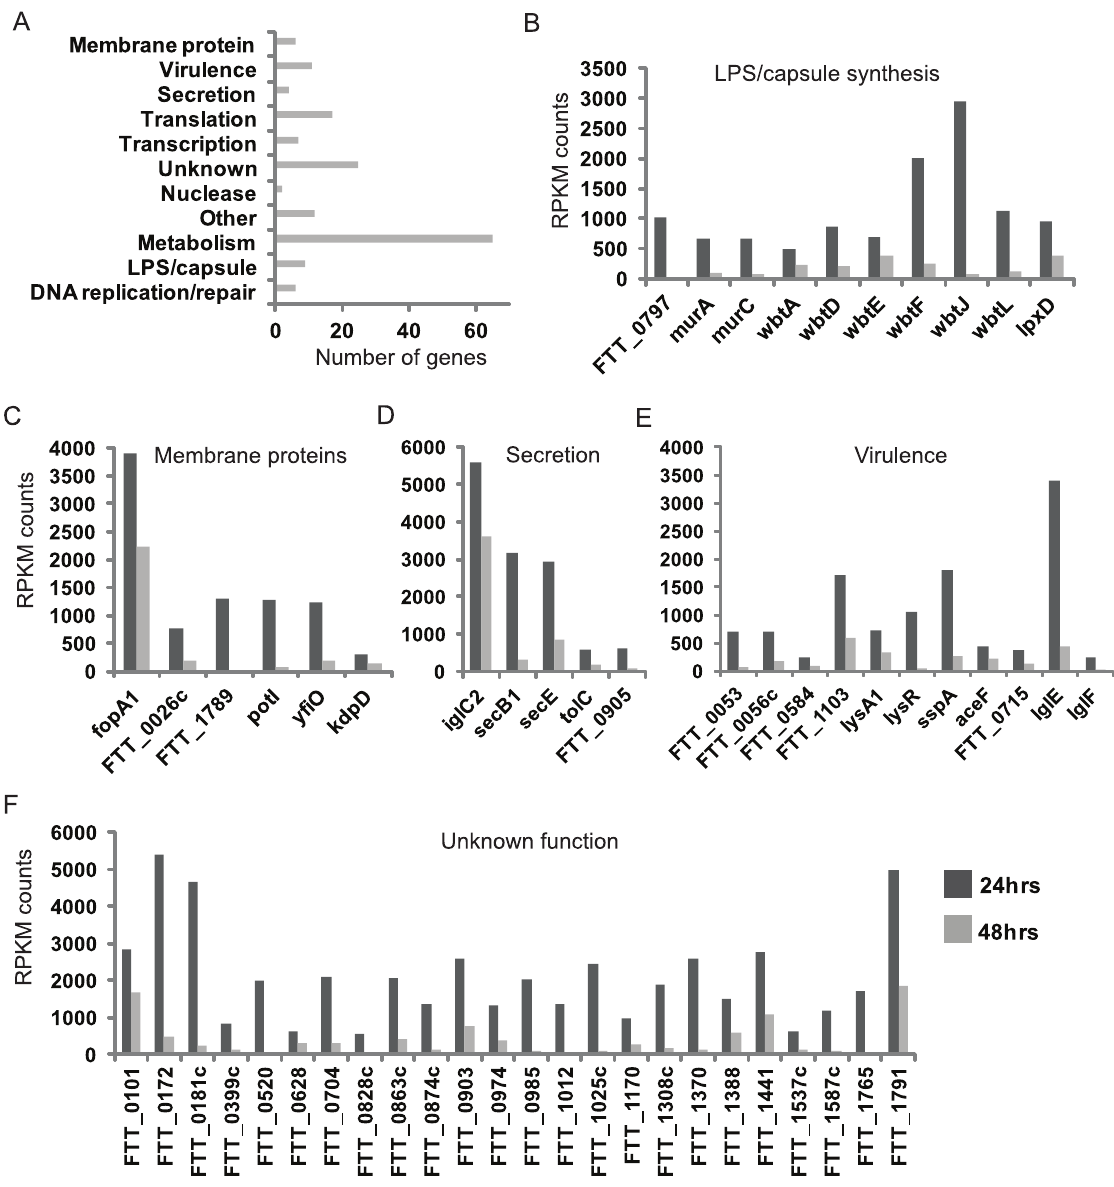
Figure 4. Activation of pulmonary inflammation between 24 and 48 hrs post-FT SchuS4 exposure correlates with altered expression levels of bacteria-specific mRNA transcripts. A. Functional distribution of Francisella transcripts detected in lung tissue that show decreased abundance at 48 hrs relative to 24 hrs post-exposure. Expression profiles of transcripts that encode genes involved in LPS/capsule synthesis ( B ), membrane proteins ( C ), secretion ( D ), virulence ( E ) and unknown function ( F ) at 24 and 48 hrs post-exposure. Expression levels are shown as normalized (RPMK) counts of detectable reads mapping to FT SchuS4 genome using RNAseq analysis of lung tissue from infected animals. For each run, samples from 3 individual animals were pooled prior to sequencing. * RPMK: reads per kilobase of gene per million reads.